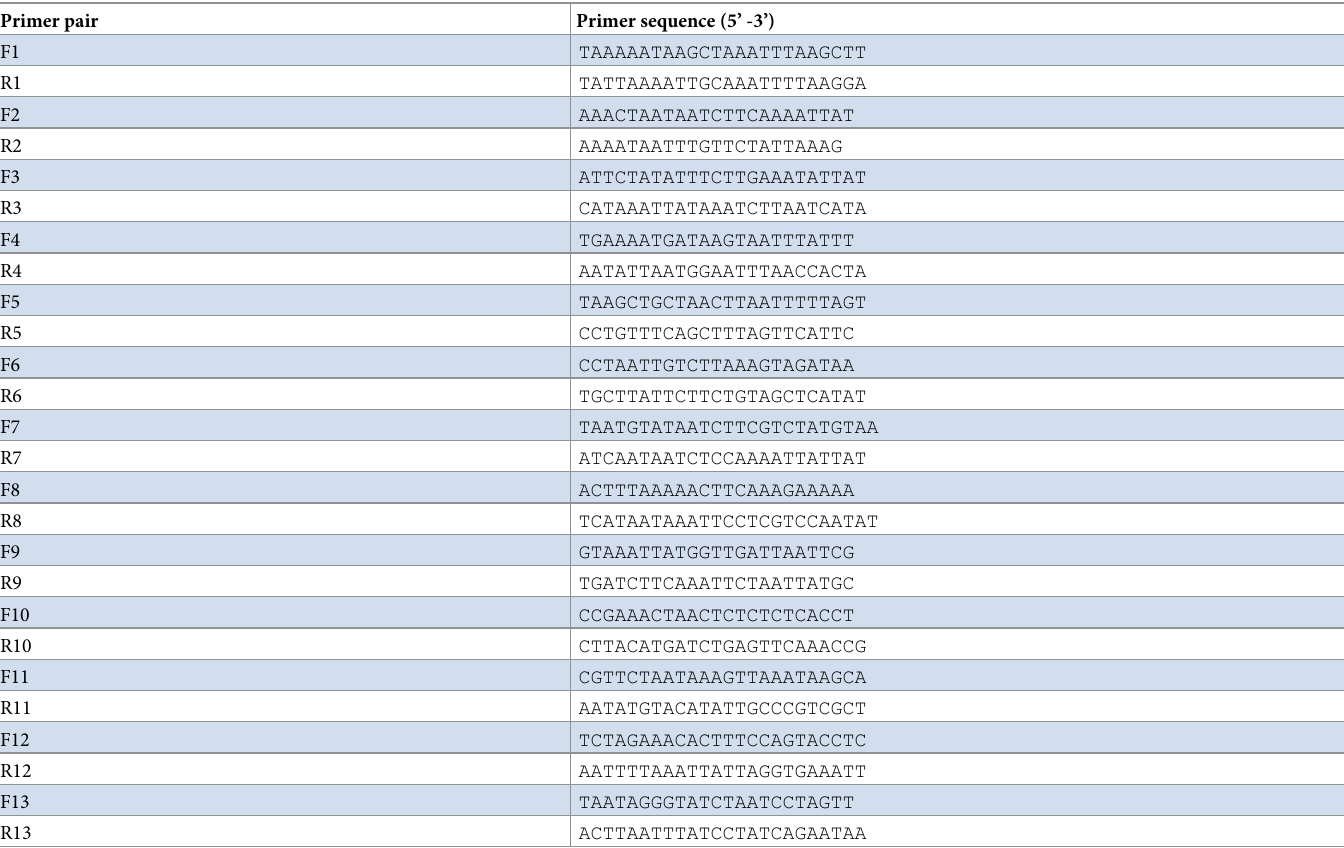
Table 1. Details of the primers used to amplify the mitogenome of O . olivacea Warre. Primer